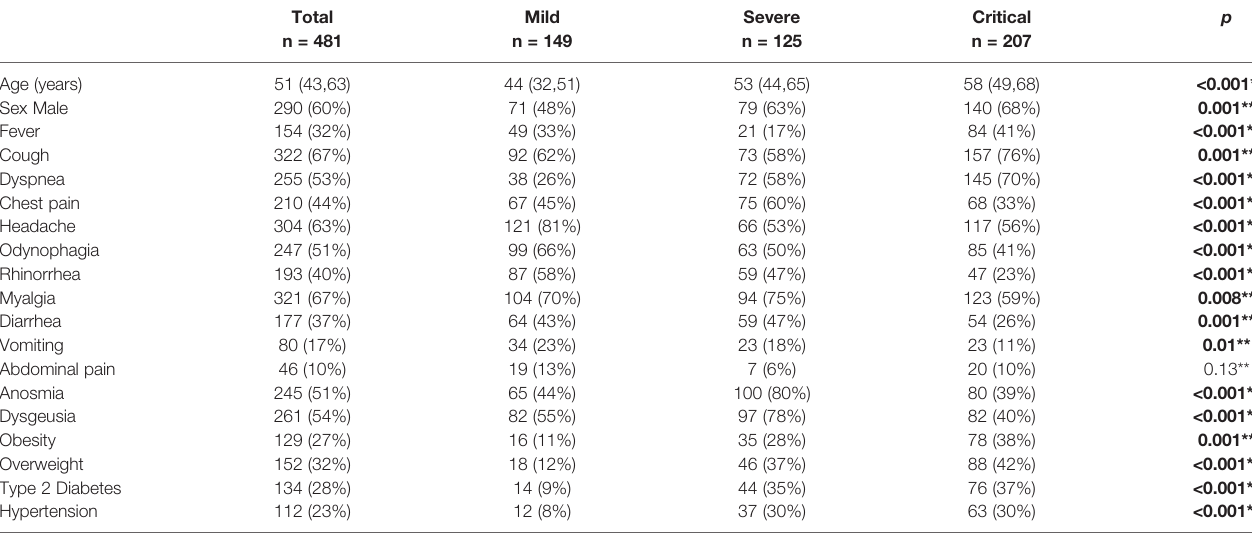
TABLE 1 | Clinics characteristics of population of study.